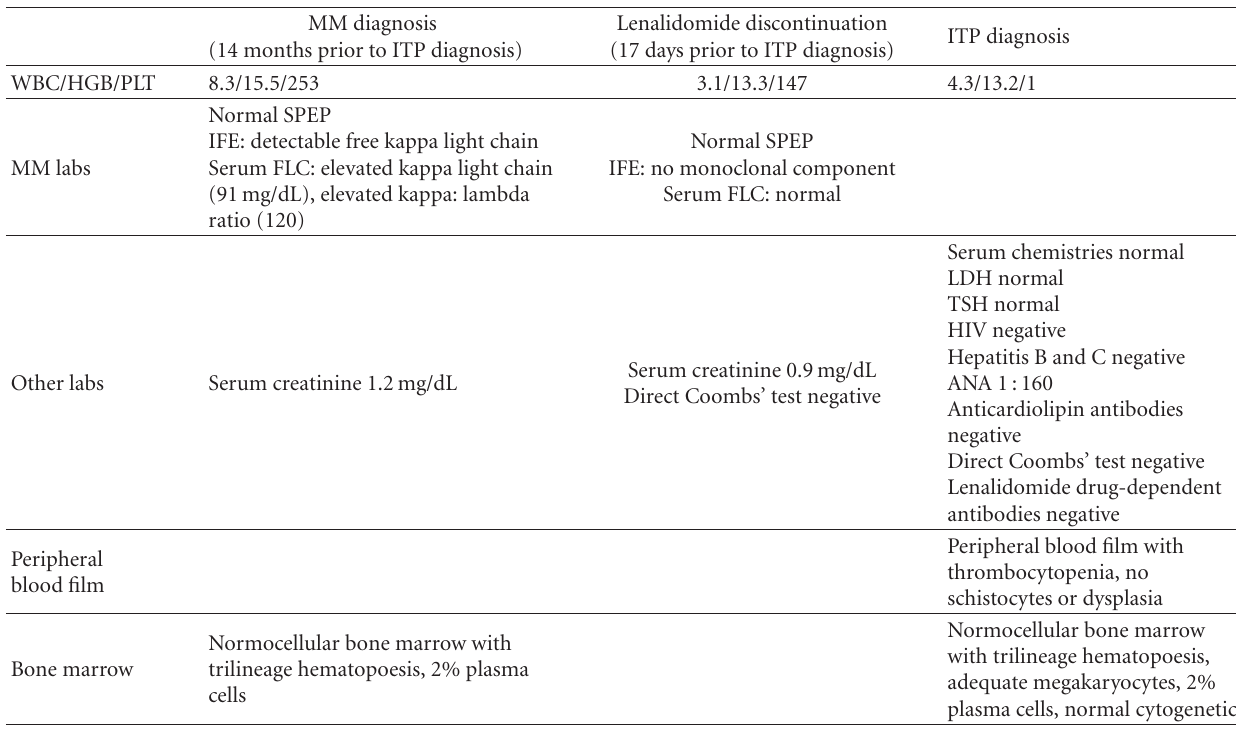
Table 1: Key clinical time points and relevant studies.